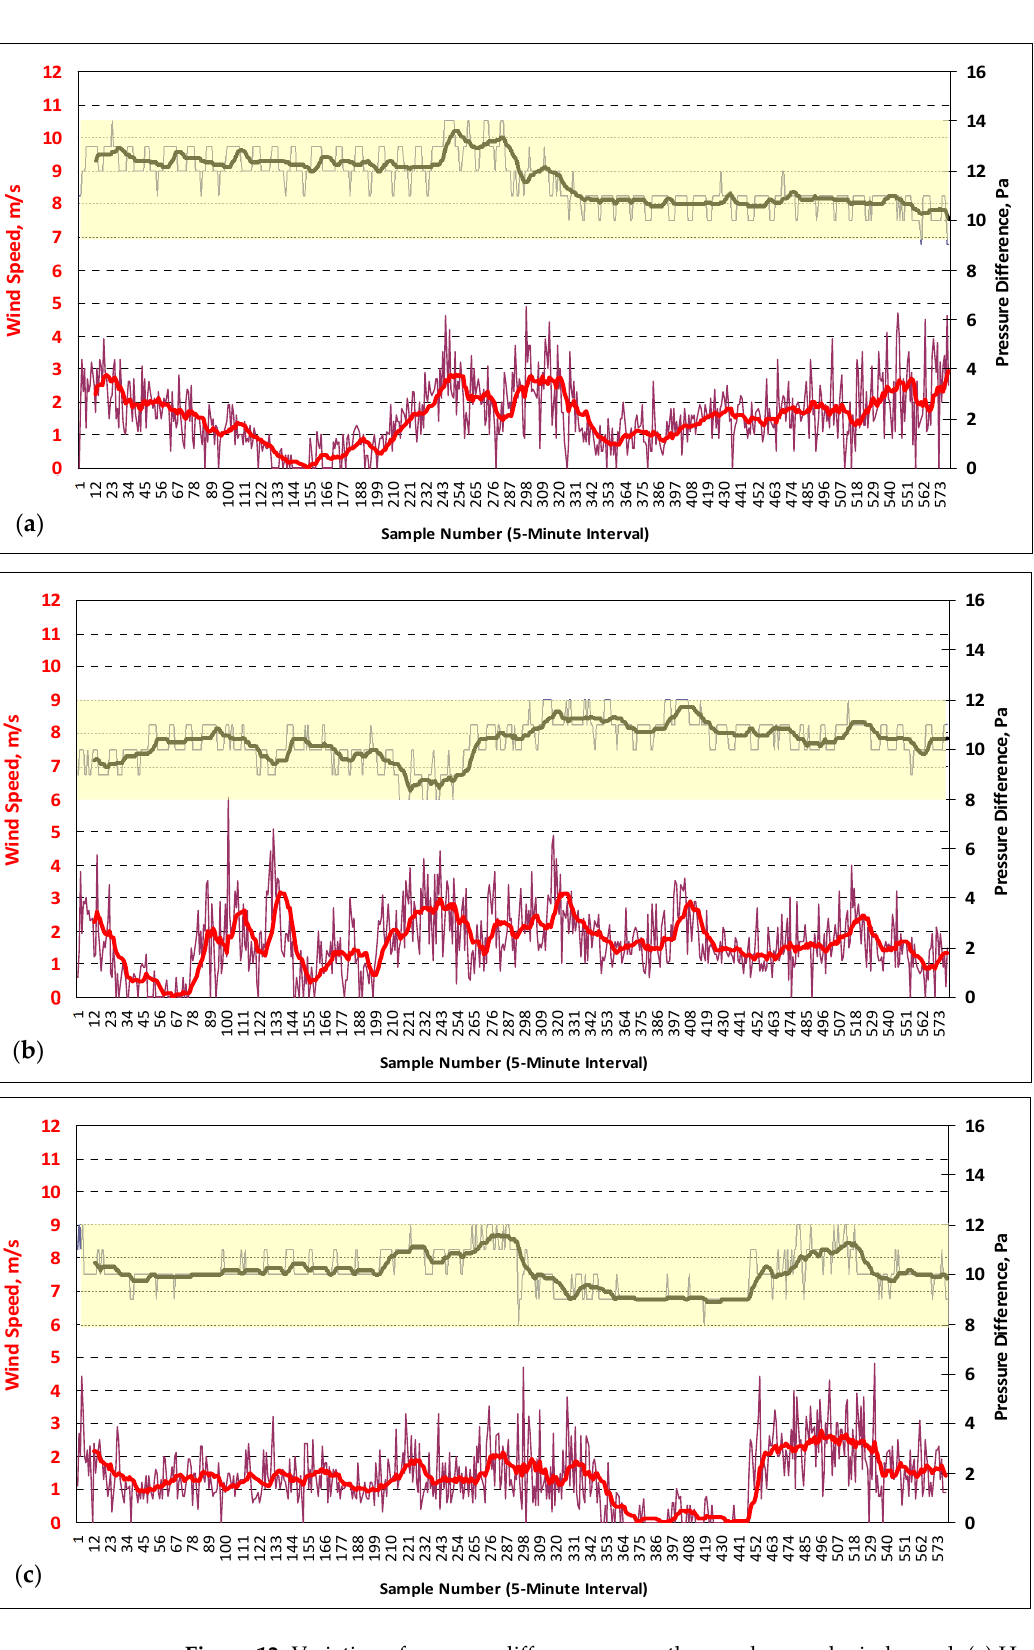
Figure 12. Variation of pressure difference across the envelope and wind speed. ( a ) House A; ( b ) and ( c ) House B. (red: trend line for wind speed; green: trend line for pressure difference; yellow zone: pressure difference range).